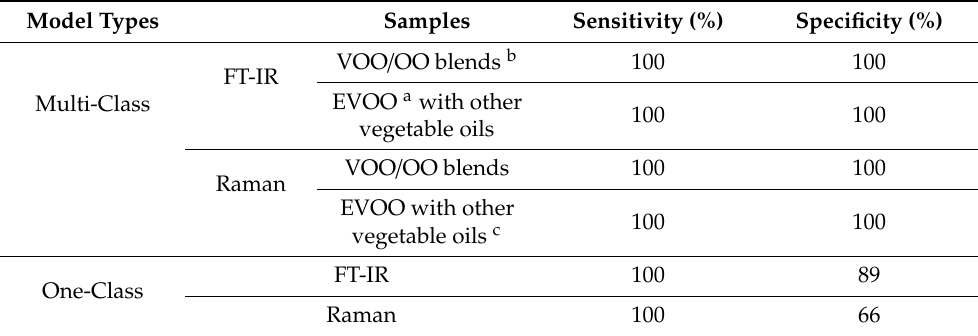
Table 3. Sensitivity and specificity values of SIMCA multi- and single-class models obtained from FT-IR and Raman